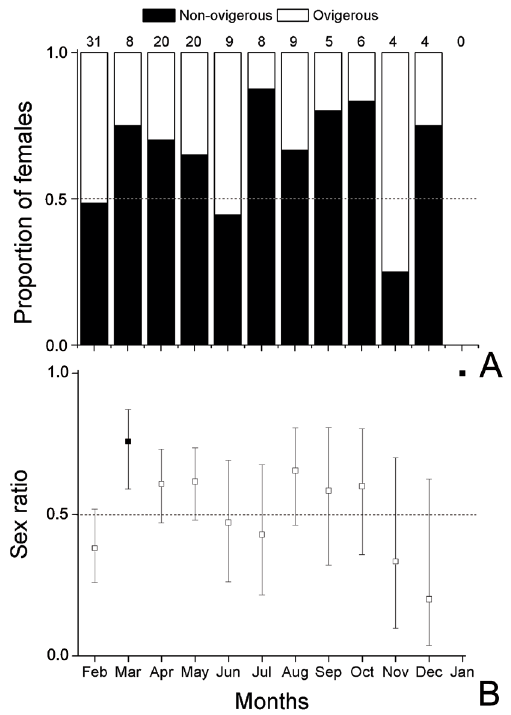
Figure 4. Atya scabra (Leach, 1816). ( A ) Proportion of adult ovigerous and non-ovigerous females and ( B ) sex ratio (estimate ± SE) during the months sampled. In ( B ), the black square indicates a deviation from a 1:1 sex ratio.